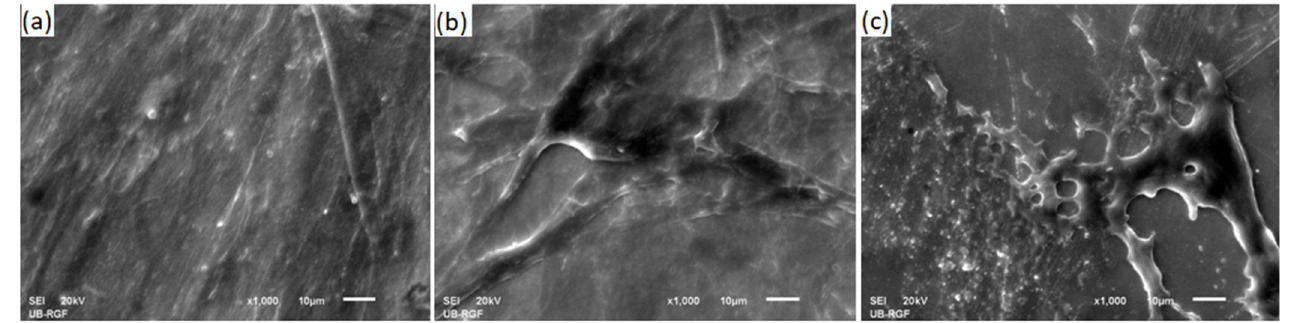
Figure 7. SEM image of fibroblast cells cultured on samples: ( a ) NiTi-1; ( b ) NiTi-2; ( c ) control sample (a sterile glass disc).